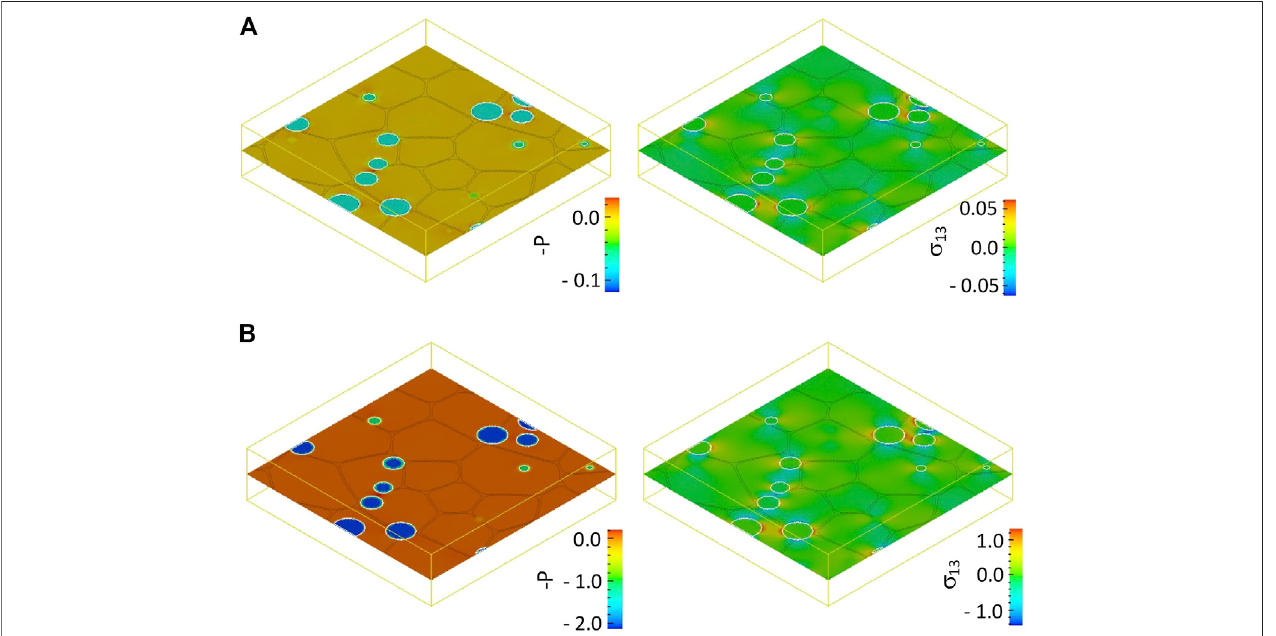
FIGURE 3 | Pressure ( P ) and shear stress ( σ 13 ) distributions on the plane S for gas bubbles with internal pressures of (A) 0.07 GPa and (B) 2.1 GPa. The units of pressure and stress is GPa.